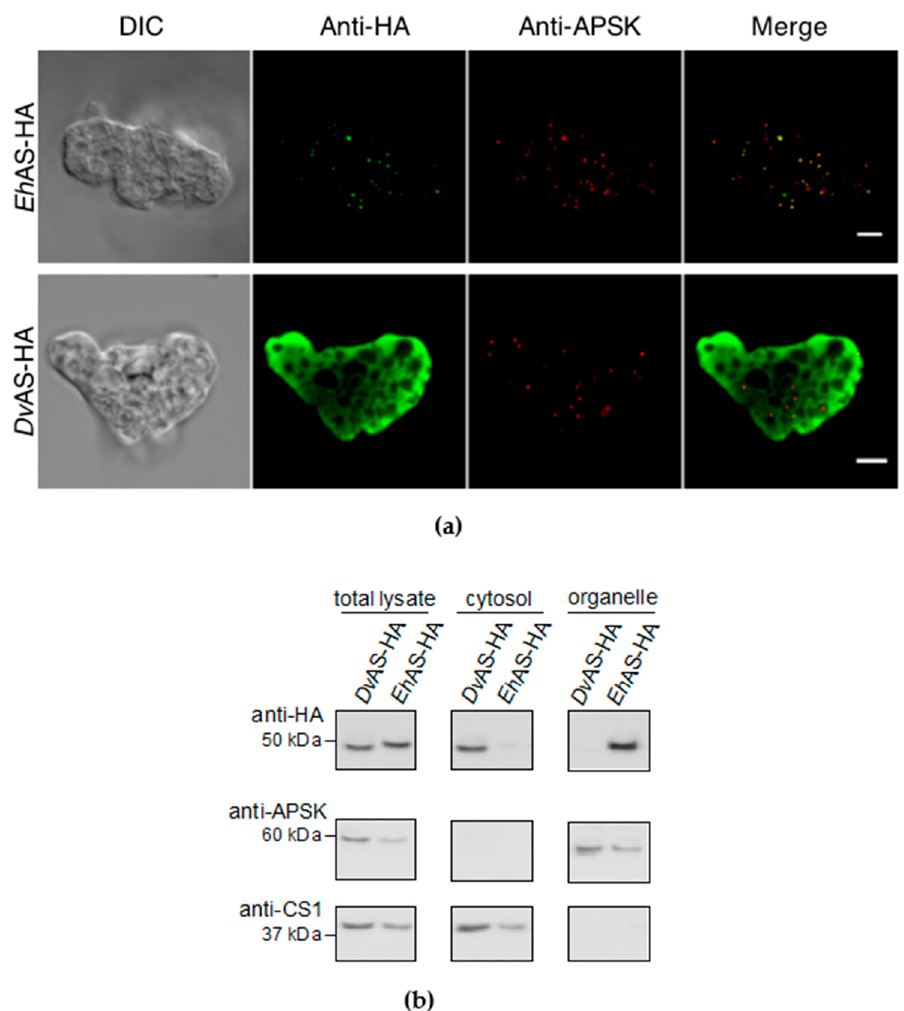
Figure 1. ( a ) Representative immunofluorescence assay (IFA) micrographs of wildtype C-terminal hemagluttinin (HA)-tagged Eh AS (top) and Dv AS (bottom) expressed in E. histolytica trophozoites, double stained with anti-HA antibody (green) and anti-APSK antiserum (red), respectively. Scale bar, 5 µm and DIC, differential interference contrast; ( b ) Immunoblotting profiles of the total lysate, cytosol, and organelle fractions of Dv AS-HA and Eh AS-HA, respectively. Membranes were stained with anti-HA antibody (top panel), anti-APSK (organelle marker, middle panel), and anti-CS1 antisera (cytosol marker, bottom panel), respectively. Table 1. Percentage of cells expressing various HA-tagged proteins that display mitosome, mitosome and cytosol, and cytosol localization.